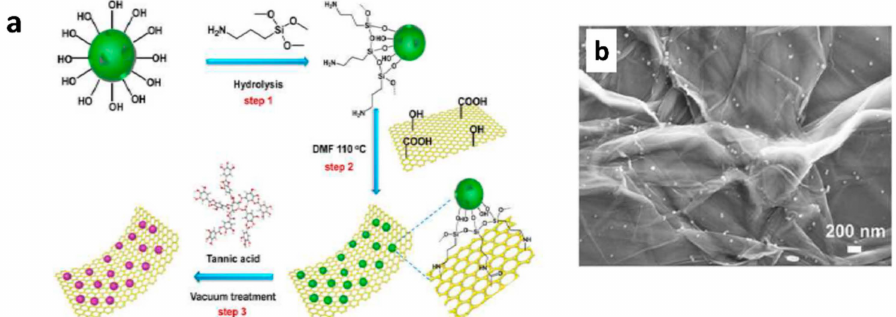
Figure 5. ( a ). Schematic representation of synthesis procedure of graphene oxide-mesoporous silicon